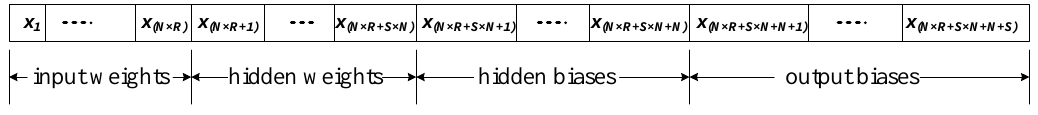
Figure 5. The vector of training parameters.